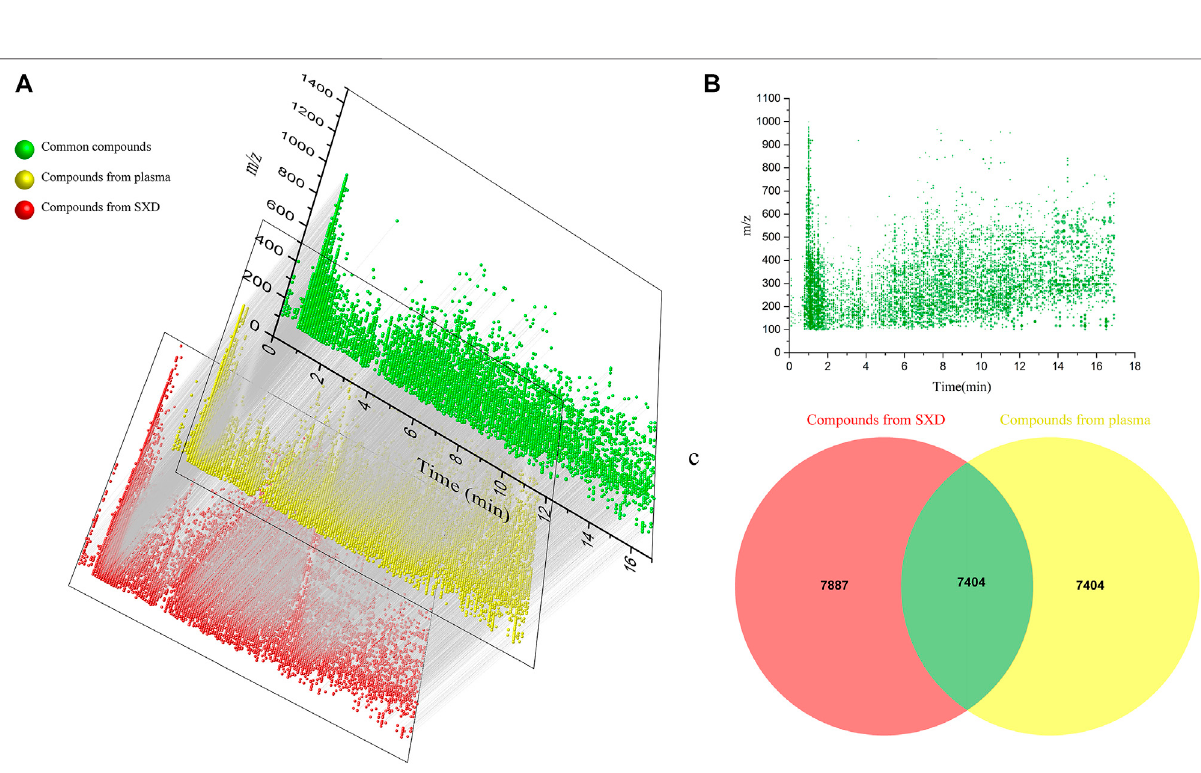
of the representative compounds and related receptors are shown in Figure 6 ; among all ligands docking with 6D6U, rosmarinic acid exhibited the lowest energies ( − 10.5 kcal/mol), which is even